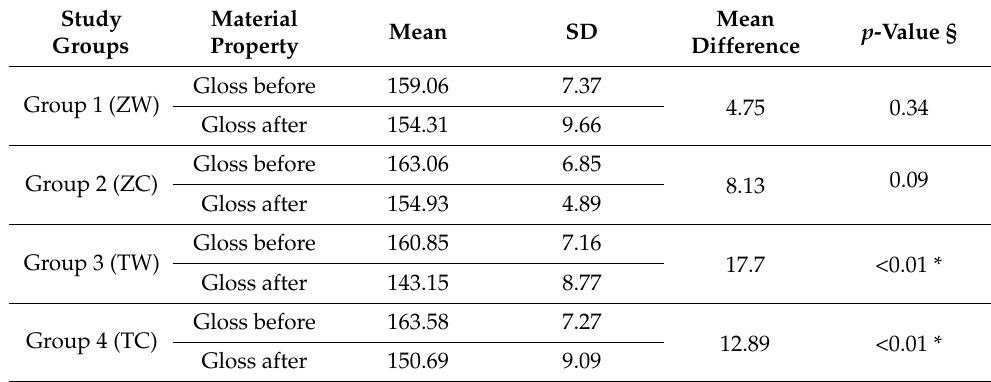
Table 6. Comparison of Mean Surface Gloss among study groups.